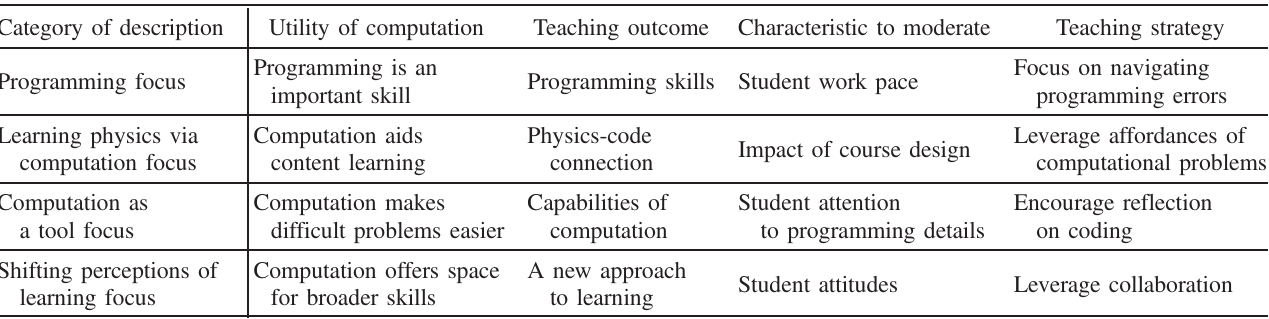
TABLE XI. Final categories of description. The programming focus treats the computational problems as a way to develop students ’ abilities to write code. The learning physics via computation focus treats the computational problems primarily as a means for learning physics concepts. The computation as a tool focus treats the computational problems as a way to help students understand the value of computation in modeling and solving problems. The shifting perceptions of learning focus treats the computational problems as opportunities to develop students ’ understandings of their own